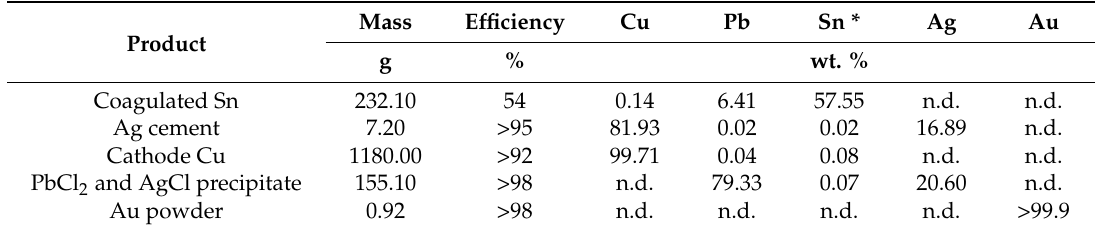
Table 9. Mass distribution, chemical composition of products, and process efficiencies.